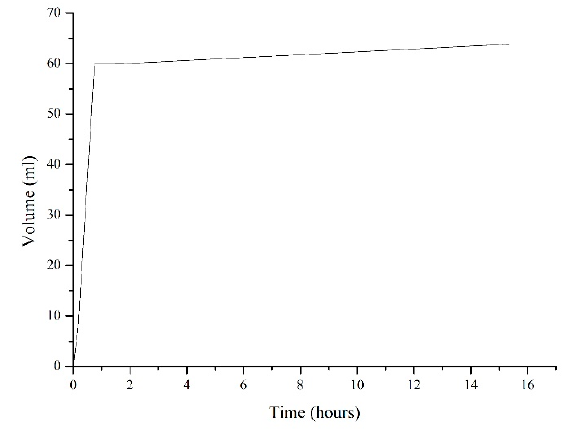
Figure 3. Volume process of injected water of stage one.